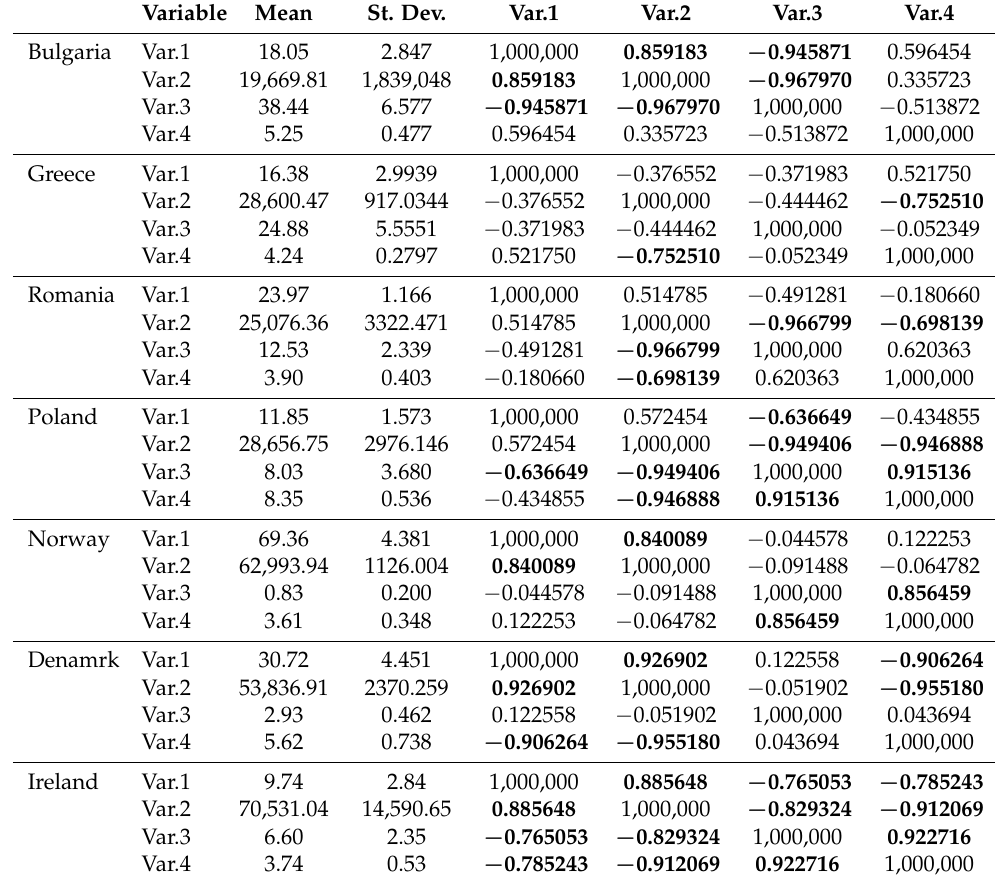
Table 1. Correlation